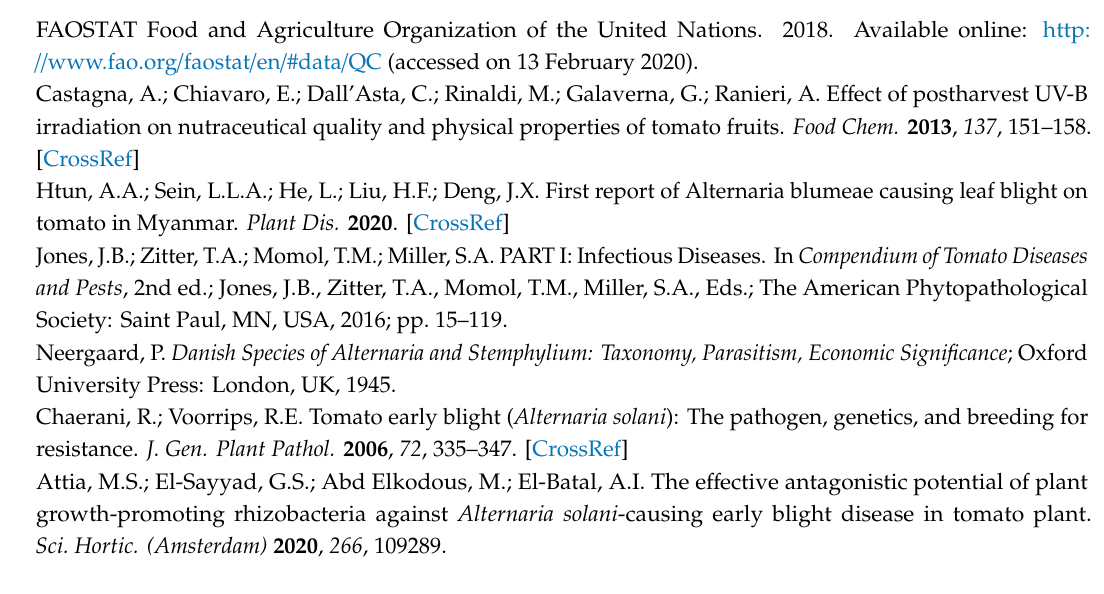
Figure S1: Chemical structure of phenolic acids used in this study. (A) Gallic acid, (B) pyrogallic acid, and (C) syringic acid. Molecular weight / molar mass (g mol − 1 ) is mentioned between parentheses beside the chemical formula of each compound. Figure S2: Morphological features of Alternaria isolates obtained from tomato commercial fields early in 2019. (A) Isolate #1, (B) isolate #2, and (C) isolate #3. Colonies were cultured on potato dextrose agar (PDA) medium in 9 cm Petri dishes and incubated at 25 ◦ C for 7 days. Figure S3: Simple linear regression between disease severity (%) and time post-treatment with gallic acid or its derivatives during 2019 (A) and 2020 (B) seasons. Colored circles present the row data. The fitted regression line is presented as a solid-line, while the 95% confidence intervals for the estimated regression are color-shaded and edged by doted-lines. Regression equations, R2, and p -value based on the F test ( p < 0.05) were also obtained and presented within the